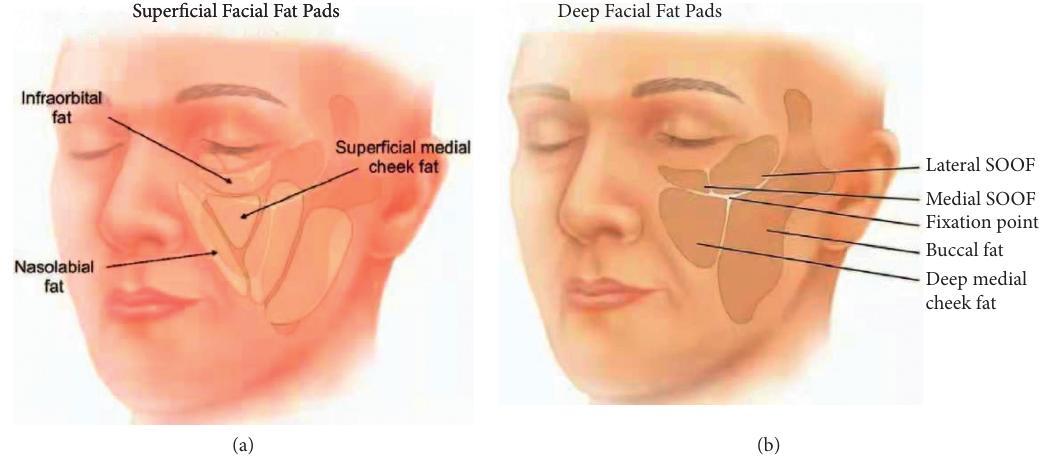
Figure 1: (a) The superficial fat (light beige) in the middle of the face includes the superficial fat on the inner side of the cheek, the fat in the nasolabial groove, and the fat within the orbit. (b) The midface deep fat (dark tan) compartment consists of the deep fat compartment of the inner cheek and the inner part of the buccal fat pad